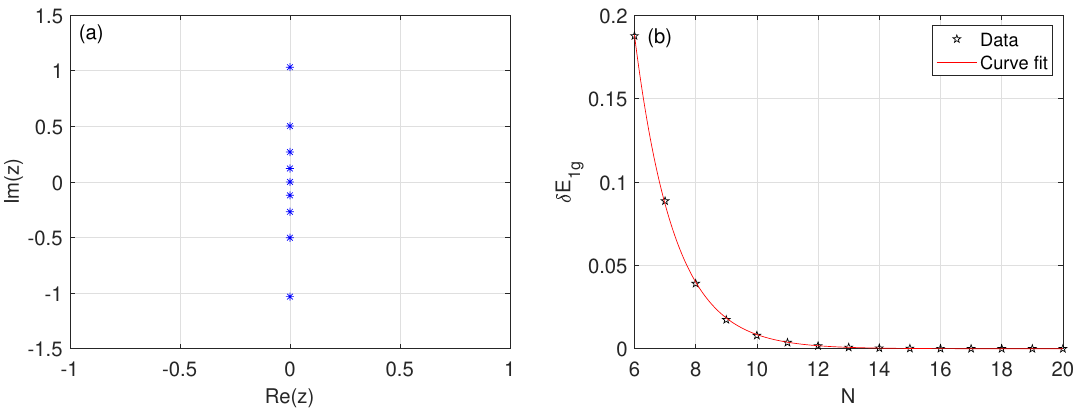
Figure 2 . (a) The distribution of zero roots { z j } of Λ( u ) at the ground state for N = 10 and η = 0 . 75 via exact diagonalization. (b) The difference δE 1 g between the ground state energy calcu- lated from eq. (4.15) and that obtained via numerical exact diagonalization of the Hamiltonian (2.1). The data can be fitted as δE 1 g = 19 . 52 e − 0 . 7738 N